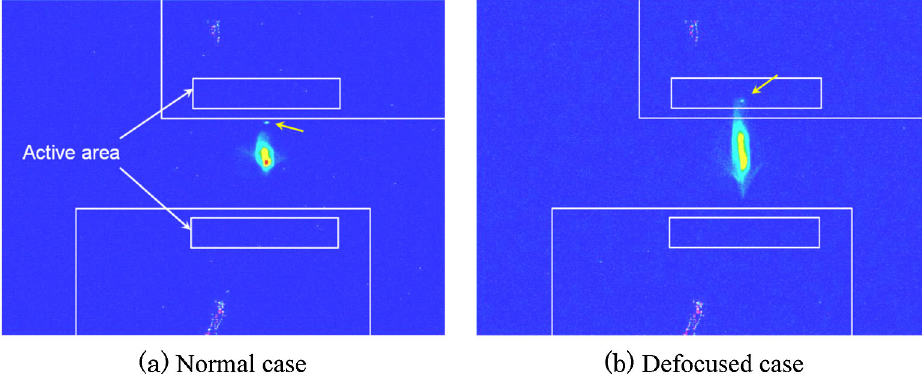
FIG. 13. OTR images. The spots indicated by yellow arrows are due to satellite bunches.